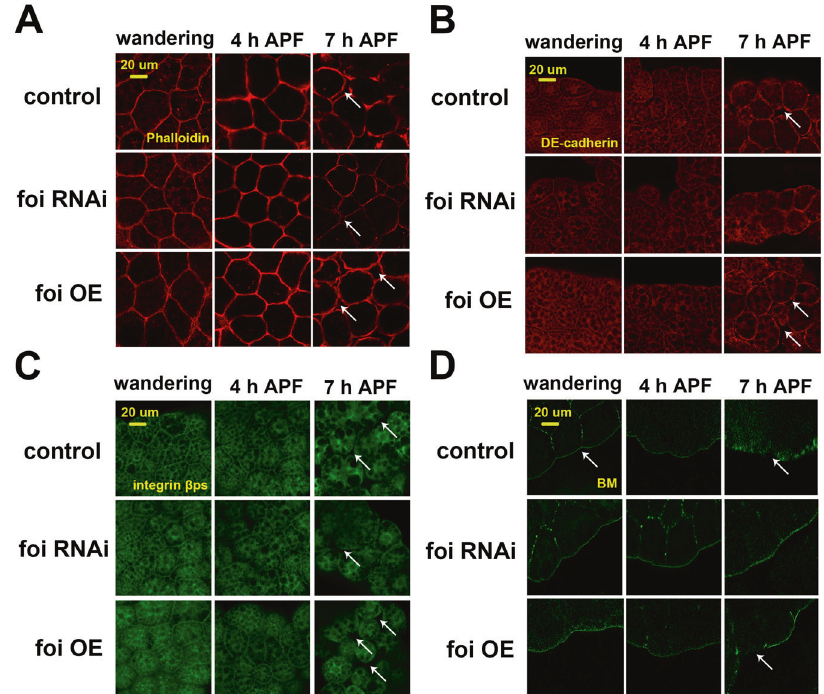
Fig. 3 Foi is required for the structural stabilization of fat body cells. The fat body structure was investigated with four hallmarks at the wandering stage, 4 h APF and 7 h APF. A Phalloidin staining revealed the shape of the fat body cells. B , C Immunostaining of DE-cadherin ( B ) and integrin β Ps ( C ) were used to monitor the cell – cell junctions and cell – basement membrane (BM) junctions, respectively. D Viking-GFP revealed the integrity of the BM. A nearly intact BM was observed in the fat body of Lsp2-Gal4 > foi RNAi animals, while the BM was broken in Lsp2-Gal4 > foi OE animals. w1118 fl ies driven by Lsp2-Gal4 serve as a blank control. The arrows in ( A – C ) indicated the gaps between cells, and the arrows in ( D ) showed the degraded